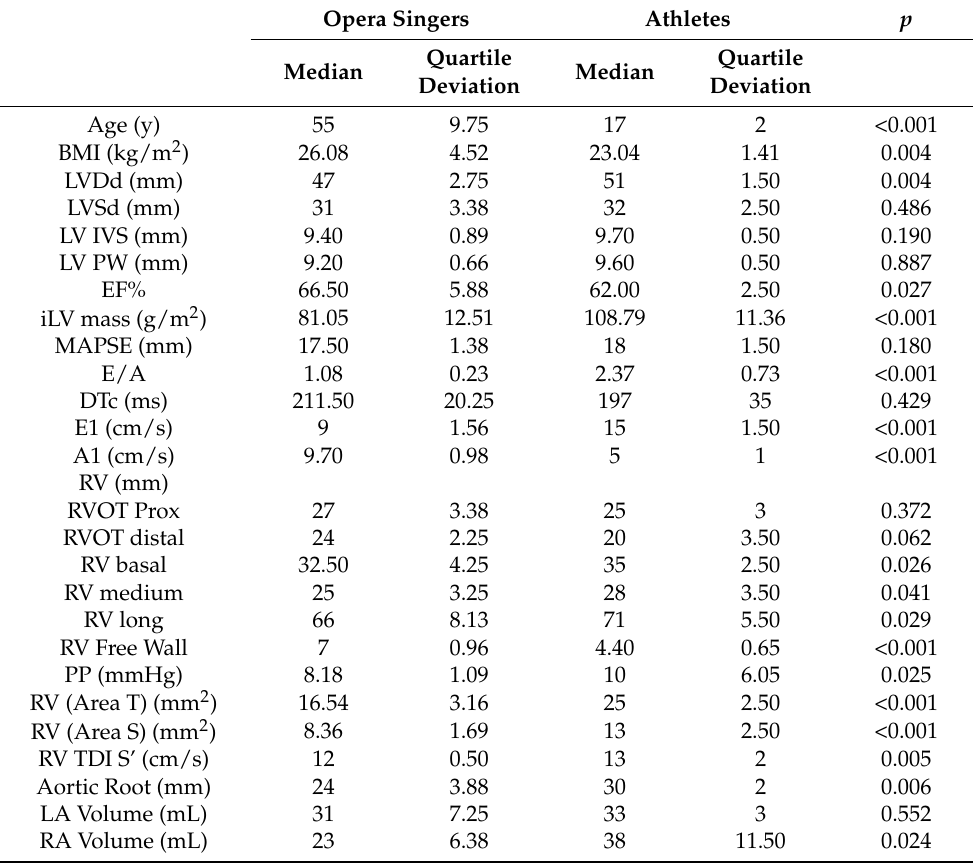
Table 1. General and 2D-echocardiographic parameters of left and right chambers. Opera Singers